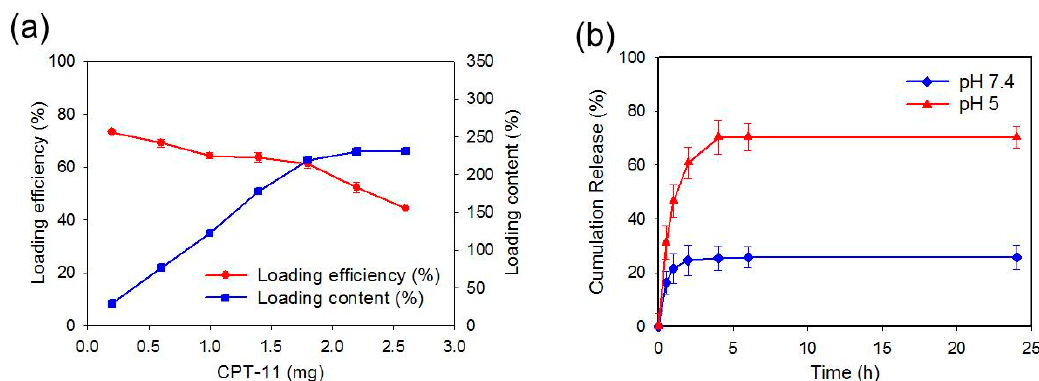
Figure 4. ( a ) Drug loading efficiency (weight percentage of initial CPT-11 loaded on GO-CET) and drug loading content (weight of CPT-11 loaded per unit weight of GO-CET) when a drug solution with different amounts of CPT-11 was reacted with 0.5 mg GO. ( b ) CPT-11 release from GO-CET/CPT11 at pH 7.4 and pH 5 in PBS (37 °C).